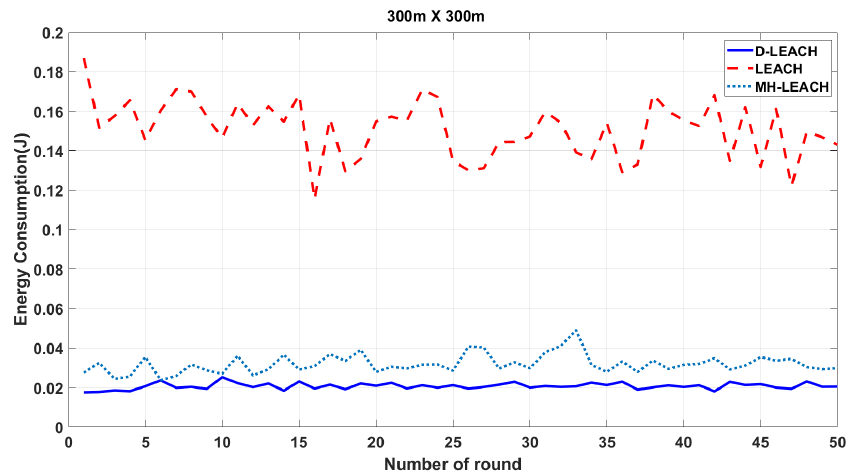
Figure 20. Energy consumption (300 × 300 m 2 ).